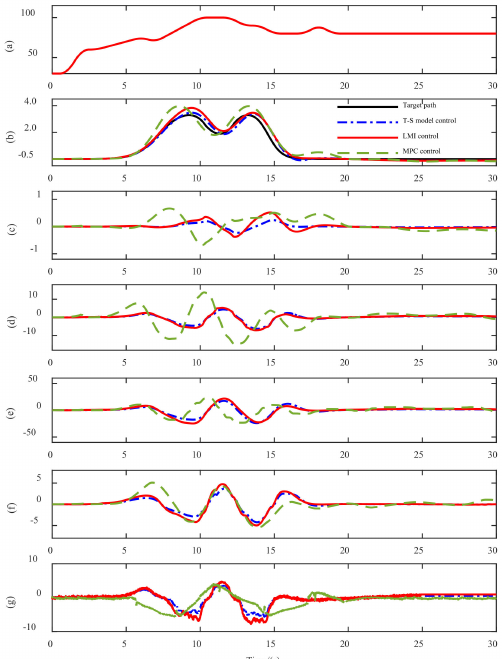
Figure 8. ( a ) Speed (km/h), ( b ) lateral displacement (m), ( c ) deviation (m), ( d ) steering torque control input (Nm), ( e ) steering angle ( ◦ ), ( f ) yaw rate ( ◦ /s), and ( g ) motor current